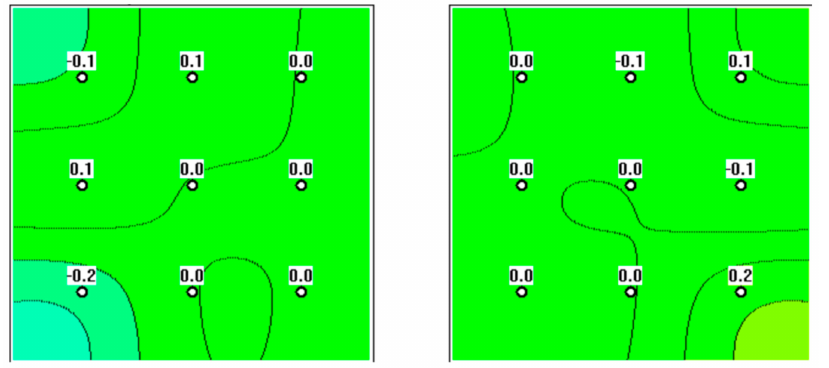
Figure 1. Microwave radiometry (MWR) assessment of a 65-year-old subject. The ovaries are normal, with no signs of focal hyperthermia.